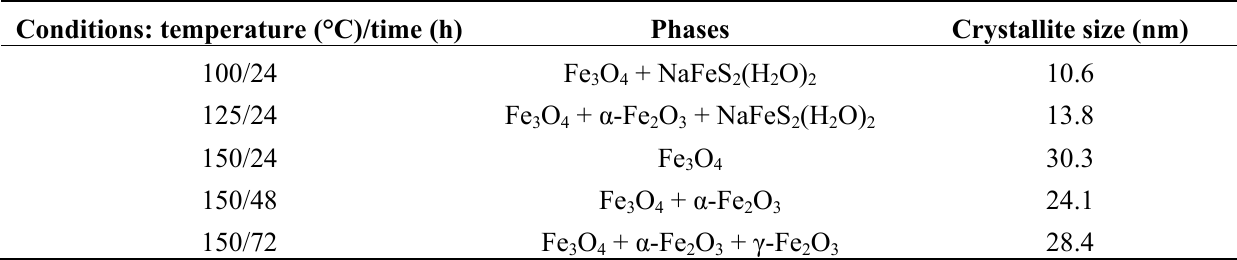
Table 2. Influence of reaction temperature and time on the phases of nanostructured iron oxides and crystallite sizes. All samples are prepared using PEG:H Reprinted with permission from [19]. Copyright 2008 Elsevier